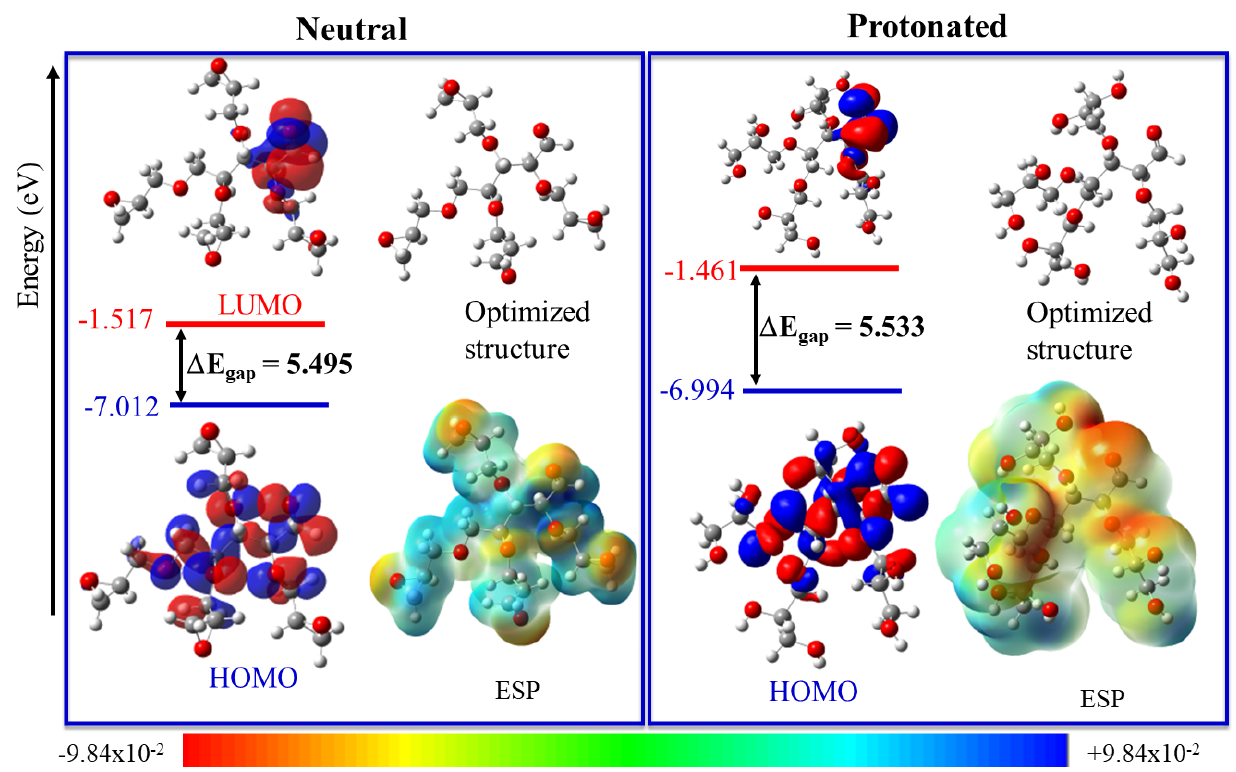
Figure 7. Optimized structures, 3D-plot electrostatic potential map and 3D-Iso-surface densities of HOMOs and LUMOs, and the energies and energy gaps (in eV) (Isovalue: 0.02 au) of the investigated epoxy resin in its neutral form ( left ) and protonated form ( right ) in an aqueous solution using a B3LYP/6-31+G(d,p) level of theory with a PCM solvation model.